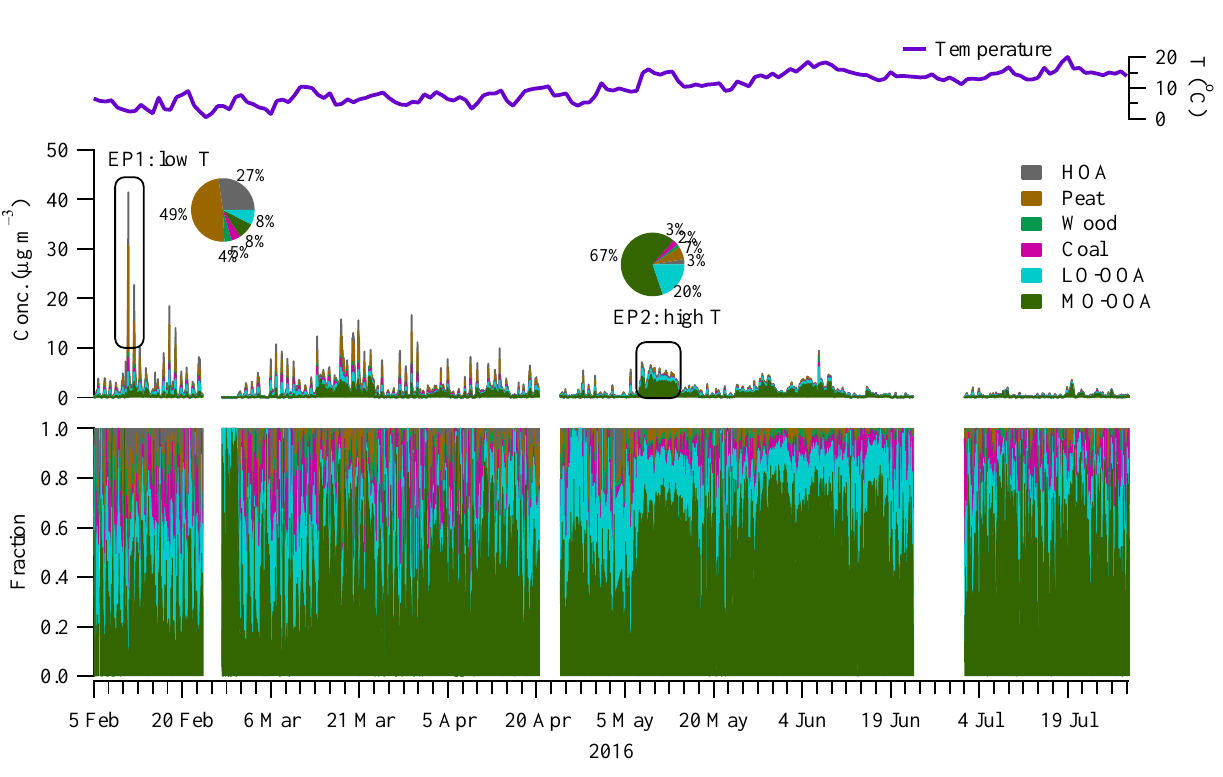
Figure 4. Time series of the OA factors (mid panel) resolved by the rolling PMF. Also shown is the time series of the temperature (top panel) and the relative fraction of each factor (bottom panel). Two episodic pollution events with one featured with low temperature (EP1) and the other with high temperature (EP2) are highlighted, with the pie charts showing the relative fraction of the factors.